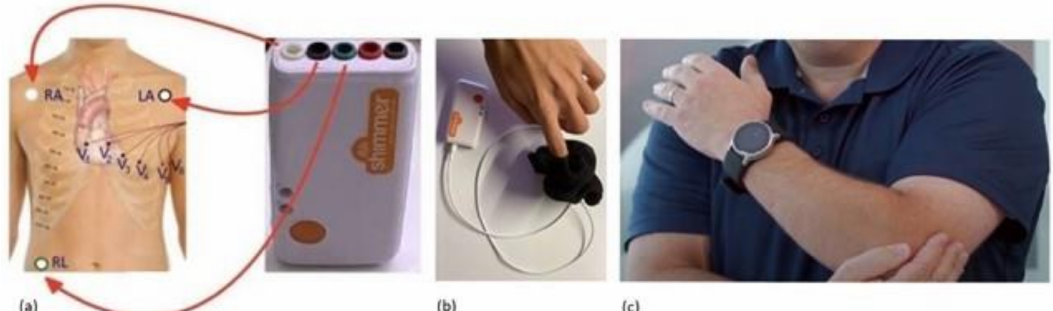
Figure 7. ( a ) ECG electrodes configuration, ( b ) PPG SHIMMER clip configuration, and ( c ) arm position while wearing the OMRON HeartGuide during recording